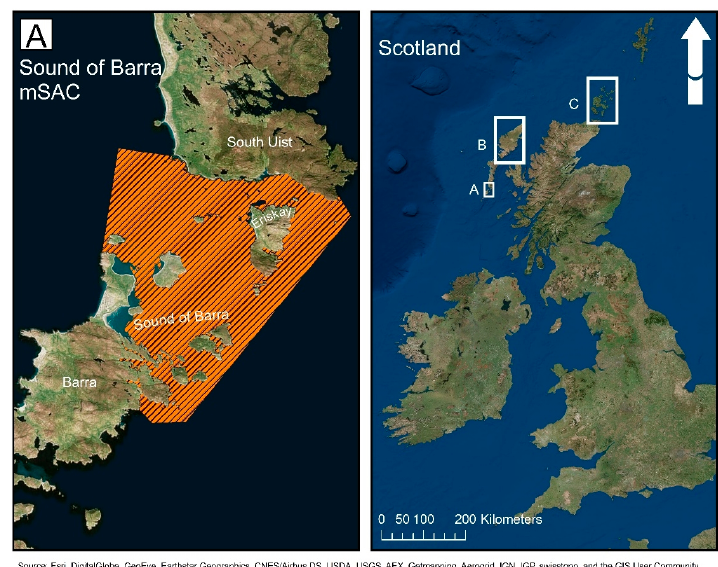
Figure 1. Case study locations with marine renewable energy (MRE) sites depicted in colour blocks.